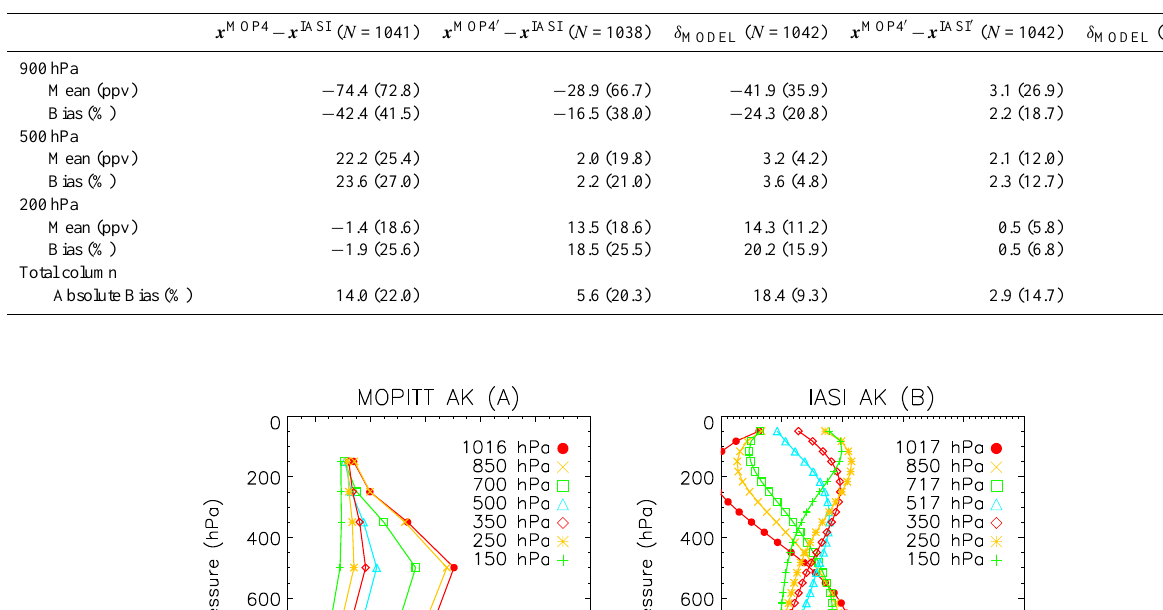
Table 2. Same as Table 1, but for IASI and MOPITT V4 CO retrievals.